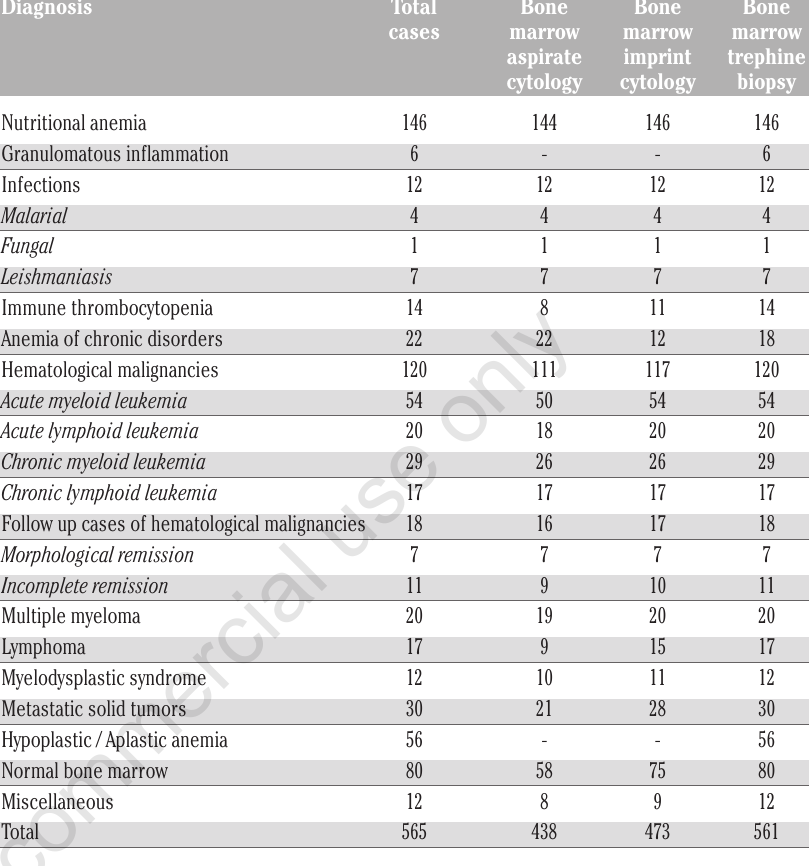
Table 1. Cases diagnosed on bone marrow aspirate, imprint cytology and trephine